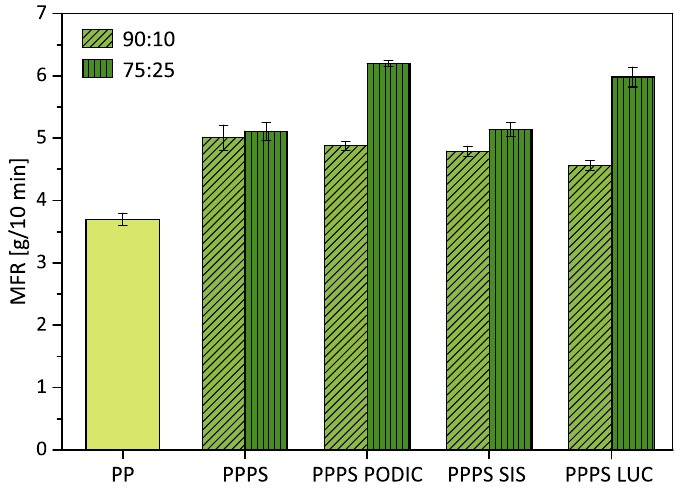
Figure 3. MFR values of virgin polypropylene (PP) and PP–polystyrene (PS) blends processed at 240 ◦ C; measured at 230 ◦